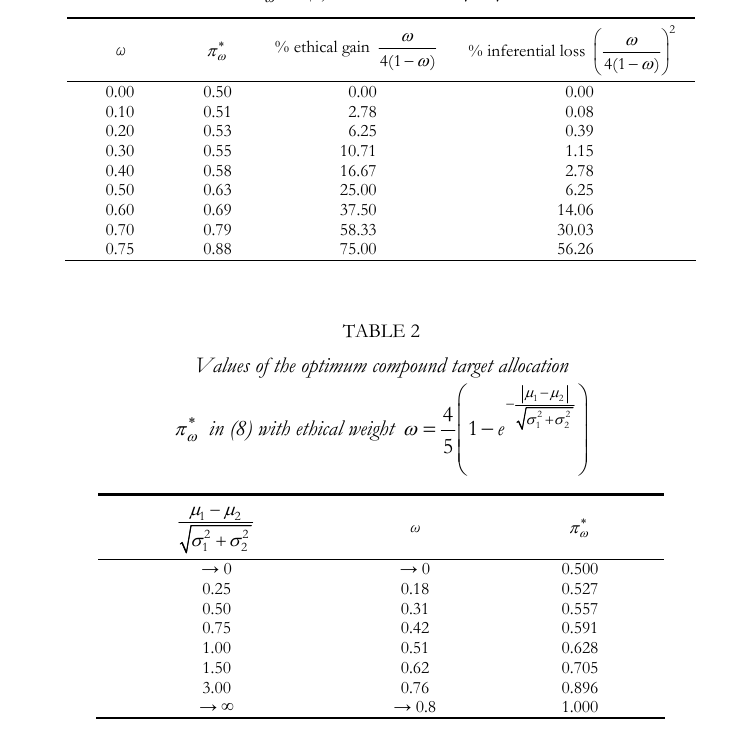
The relative ethical gain and the relative inferential loss for target  in (8) as ω varies when μ  